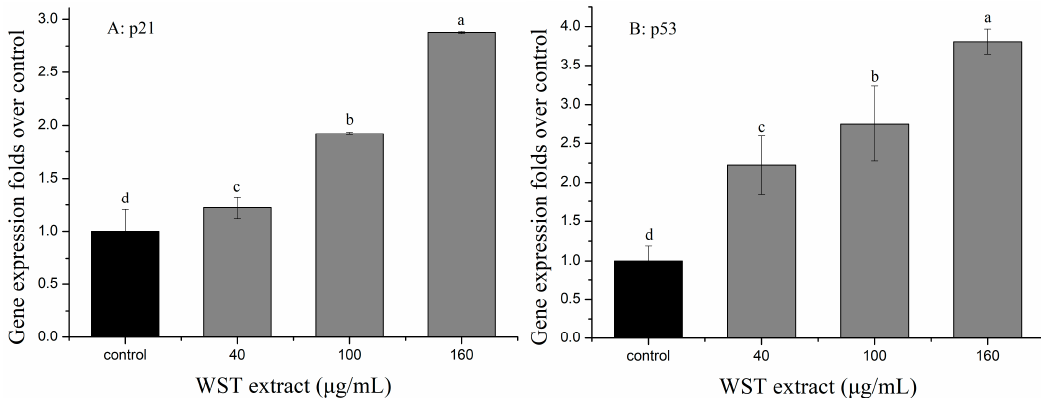
Figure 4. Effects of WST extracts on the gene expression of p21 ( A ) and p53 ( B ) in human hepatoma HepG2 cells. Fold ratio of p21 ( A ) and p53 ( B ) mRNA expression over the control. The calculation formula is as follows: gene expression/GAPDH × control numerical value (control fold ratio: 1). a–d Mean values with different letters in the same bar graph are significantly different ( p < 0.05) according to Duncan’s multiple range